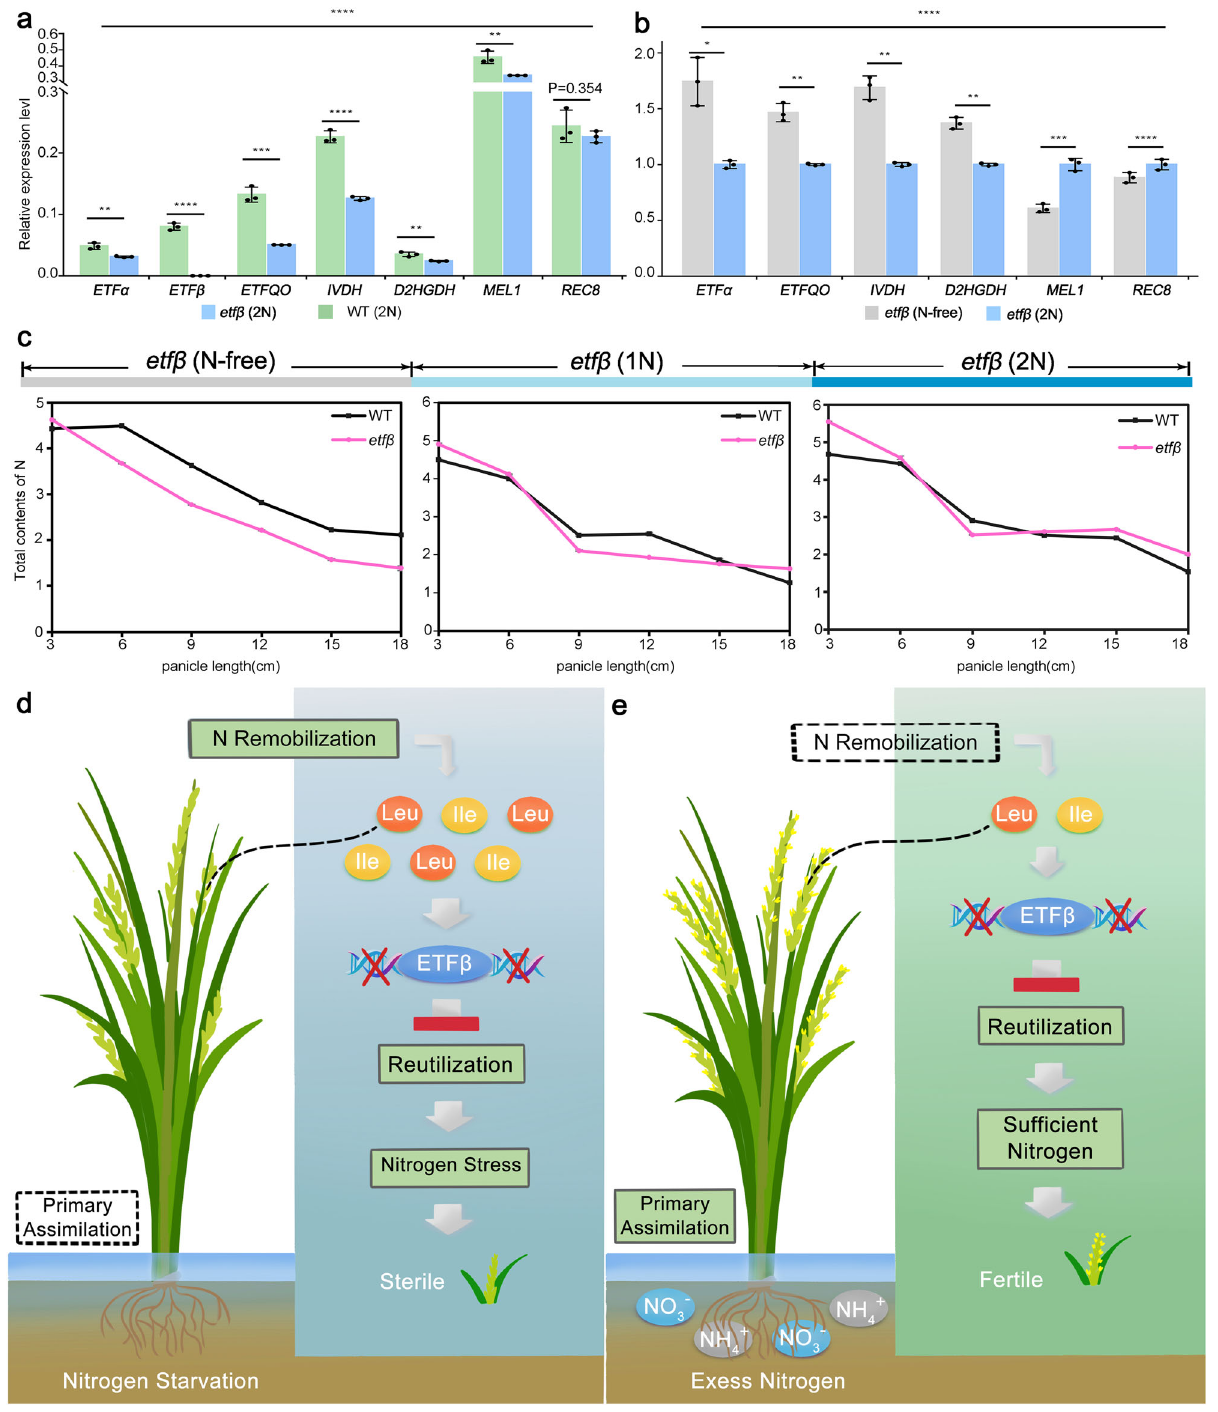
Fig. 7 N nutrition contributes to plants fertility by determining meiosis initiation. a Relative expression of ETF α , ETF β , ETFQO , IVDH , D2HGDH , and two meiosis marker genes, MEL1 and REC8 , in WT (2 N) and etf β (2 N) anthers. b Relative expression of ETF α , ETFQO , IVDH , D2HGDH , MEL1 , and REC8 in etf β (2 N) and etf β (N-free) anthers. Error bars indicate SD of three independent biological replicates in real-time PCR ( a , b ). Signi fi cance was determined by two-tailed Student ’ s t -test. ** p < 0.01, *** p < 0.001; **** p < 0.0001 ( a , b). c Total N contents of panicles in WT and etf β at six developmental stages (3, 6, 9, 12, 15, and 18 cm panicles in length) were measured under three N concentrations (N-free, 1, 2 N). The color bar indicates N concentration. Error bars indicate SD of three independent biological replicates. d , e Proposed model of ETF β function. d Sterility of etf β results from N de fi ciency in developing panicles under low N-stress conditions. e Meiosis initiation defects in etf β could be rescued by supplying excess exogenous inorganic N. Source data are provided in the Source Data fi